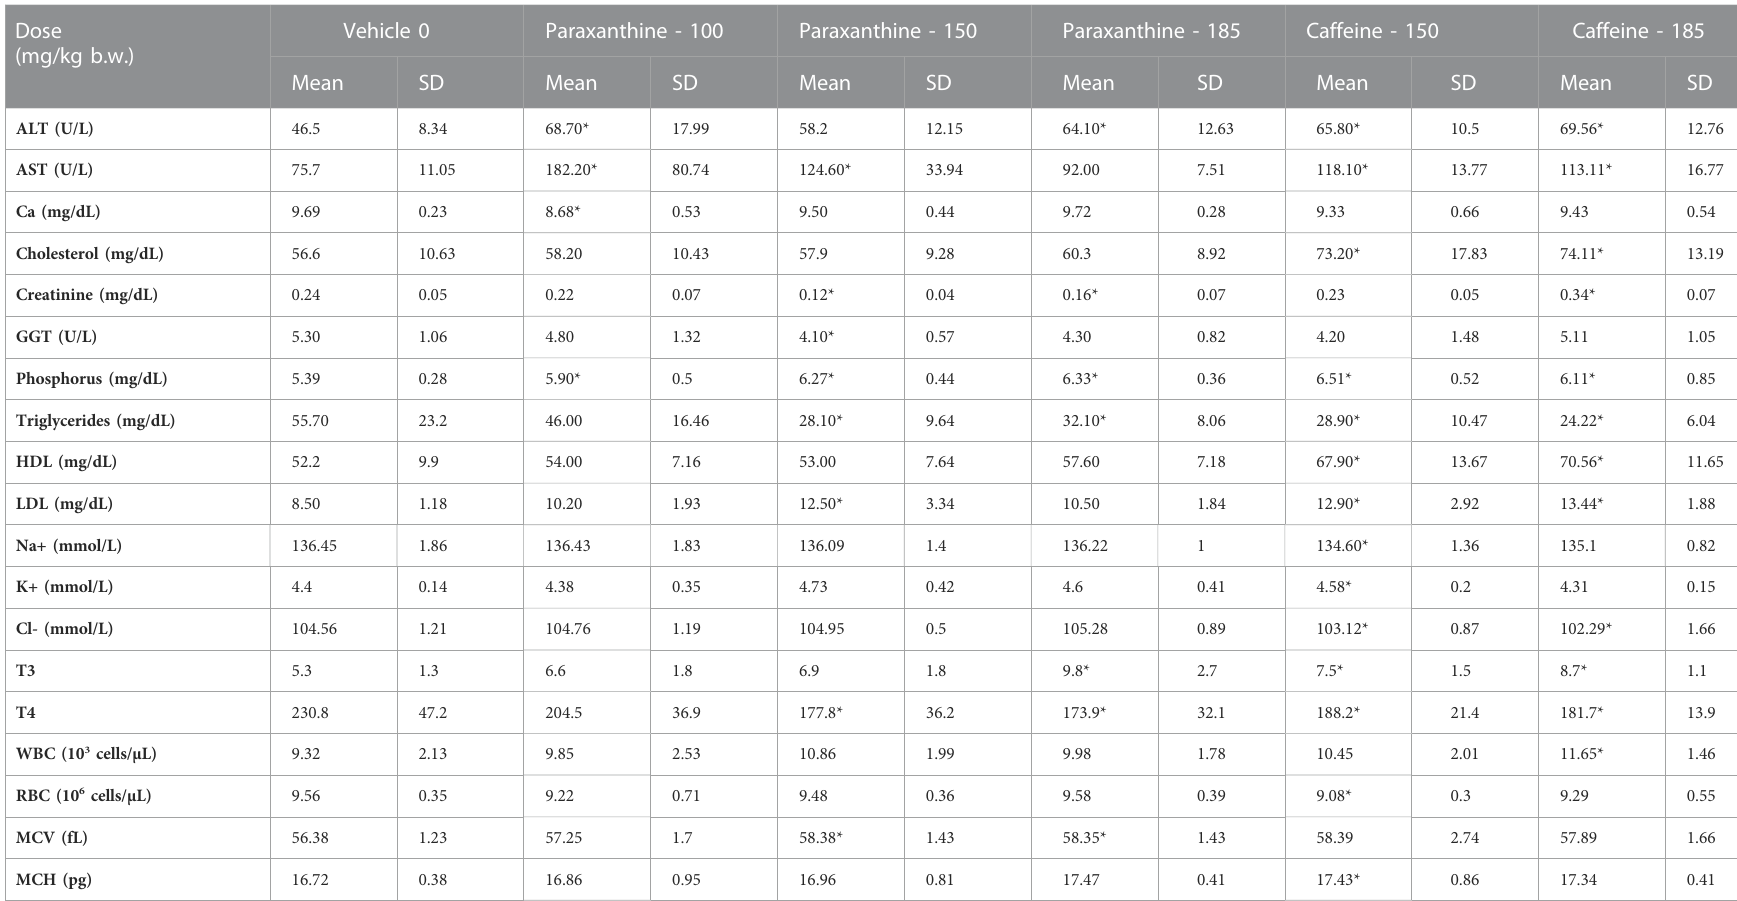
TABLE 4 Summary of clinical chemistry, hematology and hormone parameters assessed in main group males in the repeat-dose 90-day toxicity study. *Statistically signi fi cant (p < 0.05) with respect to the vehicle group. Dose (mg/kg